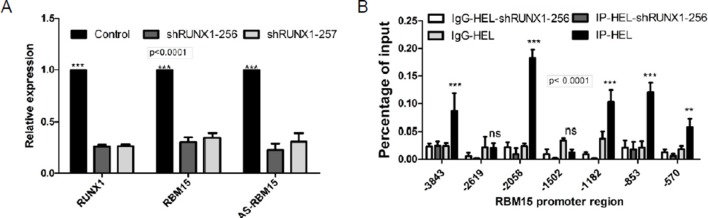
DOI:
http://dx.doi.org/10.7554/eLife.07938.032